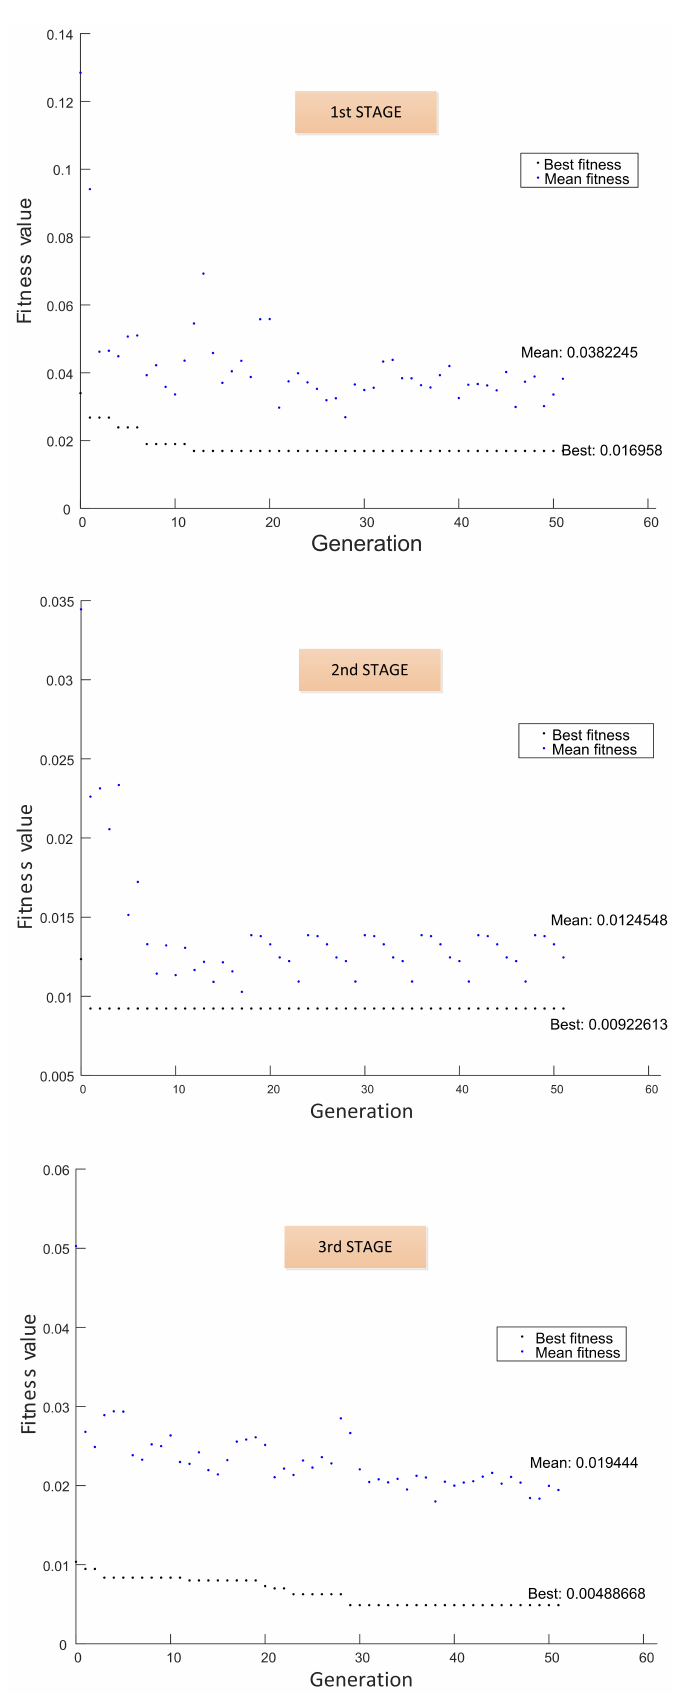
Figure 9. Fitness function